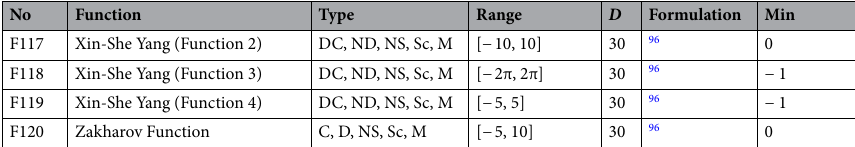
Table 3. Details of the N -dimensional benchmark mathematical functions.